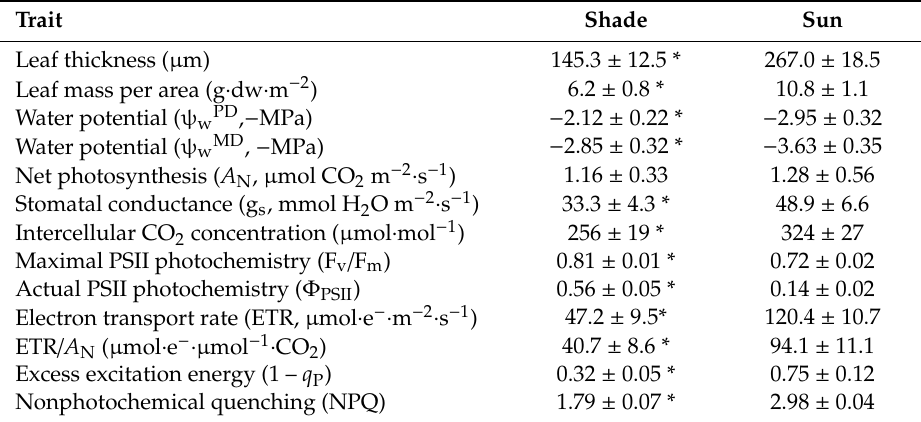
Table 1. Relevant morpho-anatomical and physiological-related traits in C. incanus adapted to full shade or fully exposed to sunlight. Leaf water potentials were measured at predawn (PD) and midday (MD). Gas exchange measurements were conducted between 12:00–13:00 h, whereas chlorophyll fluorescence-derived parameters originate from measurements performed between 12:00–14:00 h, during July. Data are means ± standard deviation ( n = 5 for ψ w , A N , and g s , n = 4 for F v / F m , Φ PSII , ETR, 1 − q P , and NPQ). Asterisks denote significant di ff erences at 5% level, using Tukey’s test. Trait Shade Sun Leaf thickness ( µ m) 145.3 ± 12.5